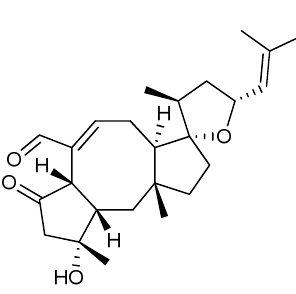
Figure 21. Ophiobolin